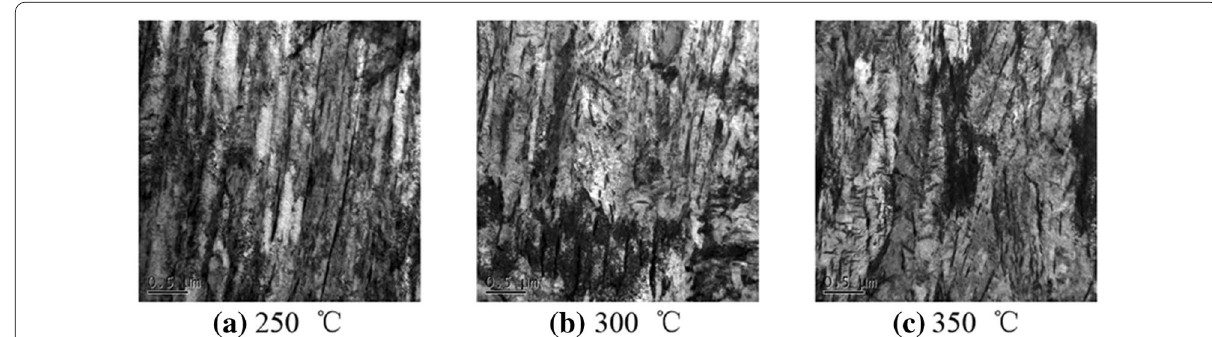
Figure 11 TEM micrographs of D-Q-P-T samples prepared using different quenching